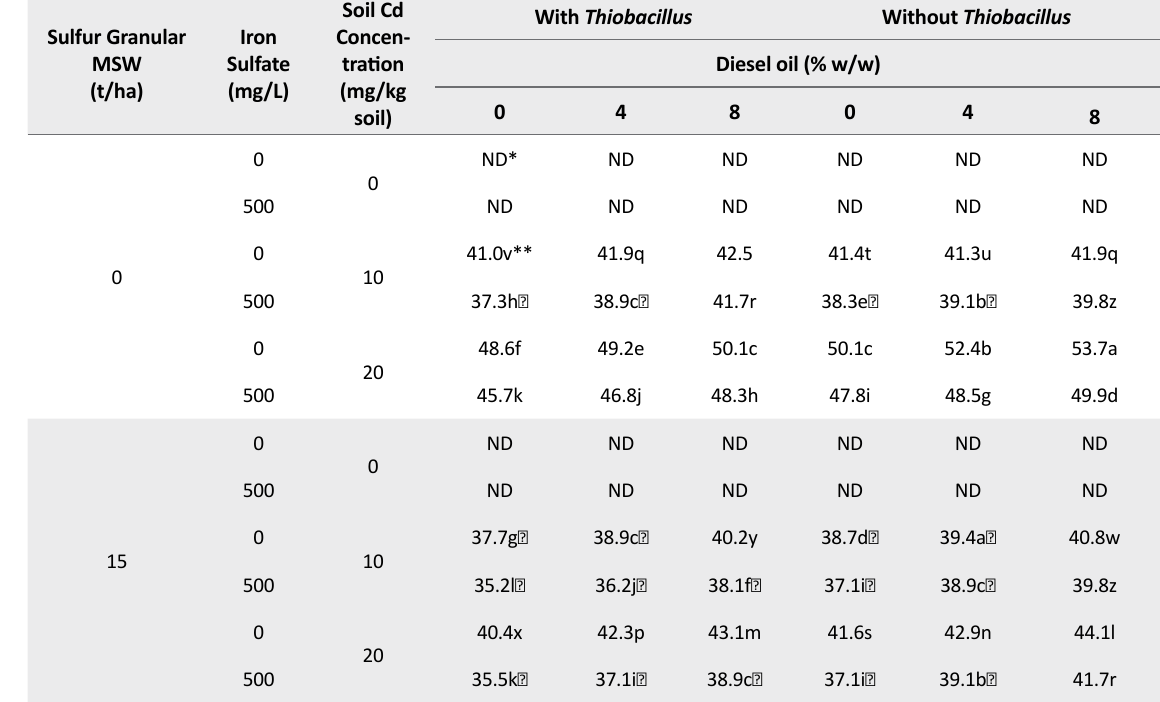
Table 4. Effect of treatments on soil Cd concentration (mg/kg) in the presence of thiobacillus